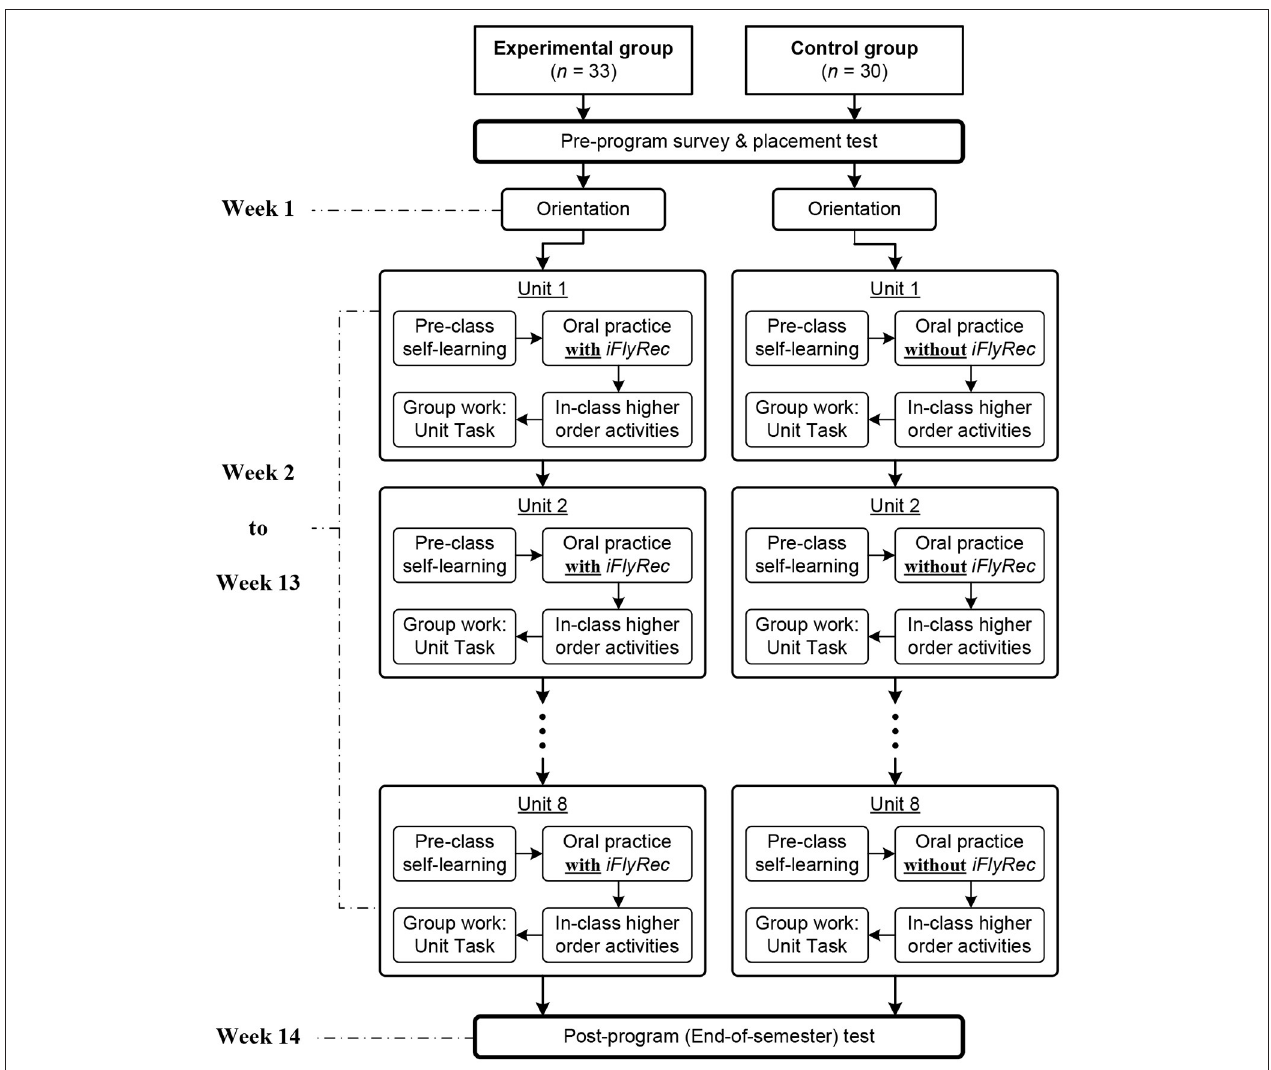
FIGURE 1 | Instructional